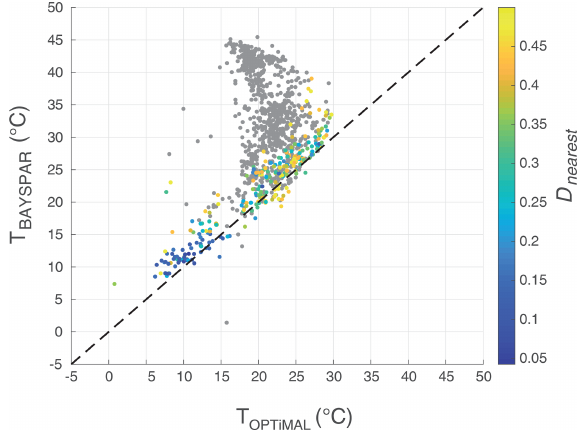
Figure 12. A histogram of normalised distances to the nearest sam- ple in the modern dataset for Eocene and Cretaceous data, excluding samples that had been screened out in previous compilations using BIT, MI and RI following the approach of Inglis et al. (2015) and O’Brien et al. (2017).